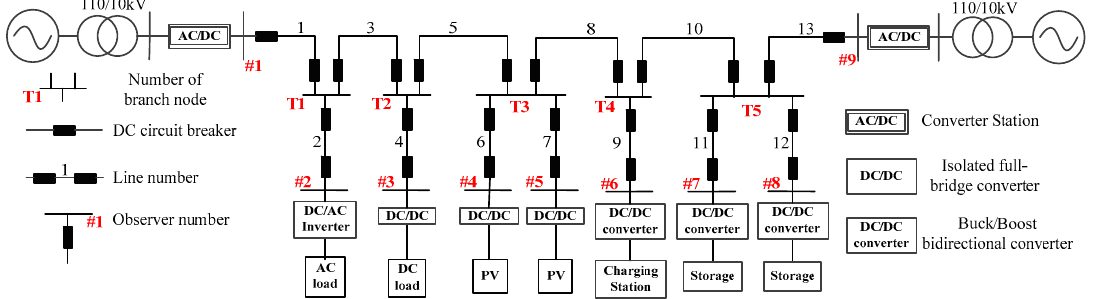
Figure 1. Single line diagram for DC distribution network.